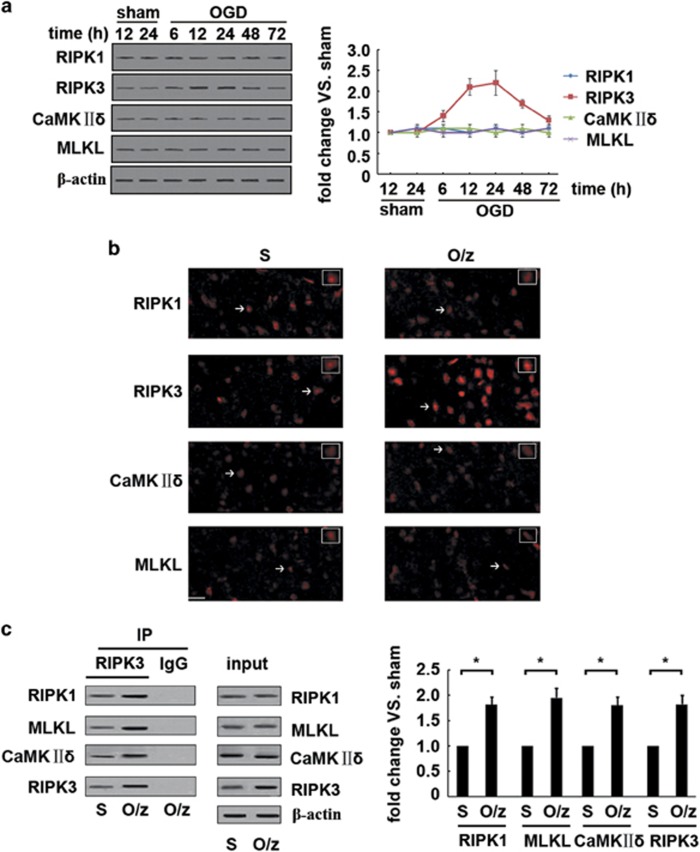
OGD/zVAD upregulates RIPK3 expression, and the RIPK3-MLKL and RIPK3-CaMKIIδ interactions without affecting RIPK1 protein expression. (a) Western blotting was used to determine protein expression levels. The ratios of the levels of the indicated proteins to that of β-actin were calculated and normalized to the value in the sham control group. We found that RIPK3 protein was upregulated 6 h after OGD and remained high until 48 h after OGD, whereas the expression levels of RIPK1, CaMKIIδ, and MLKL were not affected by the OGD insult. (b) Immunofluorescence staining 12 h after OGD indicated increased RIPK3 expression after the OGD/zVAD insult compared with the sham controls, whereas RIPK1, CaMKIIδ, and MLKL expression levels were not obviously changed. Arrows indicate representative positive staining cells, and insets show these cells at higher magnification (scale bar=40 μm). (c) Immunoprecipitation was carried out 12 h after OGD to assess the interactions between RIPK3 and RIPK1, MLKL, or CaMKIIδ. We found increases in the RIPK3–RIPK1, RIPK3-MLKL, and RIPK3-CaMKIIδ interactions after OGD/zVAD insult. Data are presented as means±S.E.M. from three independent experiments. N=6 for each group in each experiment (P<0.05, compared with the sham control). S: sham; O/z: OGD/zVAD